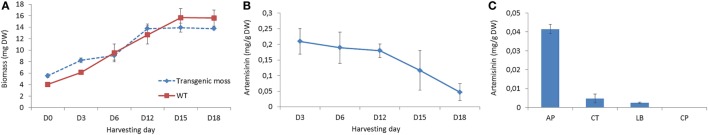
Growth and production of artemisinin in Physcomitrella patens. (A) Time course analysis of growth of transgenic and WT P. patens in liquid culture. D0 indicates the initial sub-culturing day. (B) Time course analysis of artemisinin production in P. patens. Error bars denote the SE of triplicate shake-flask liquid culture. (C) Production of artemisinin after 18 days of cultivation in different cellular component of AP, apoplast; CT, cytoplasm; LBs, lipid bodies; and CP, cell pellet.